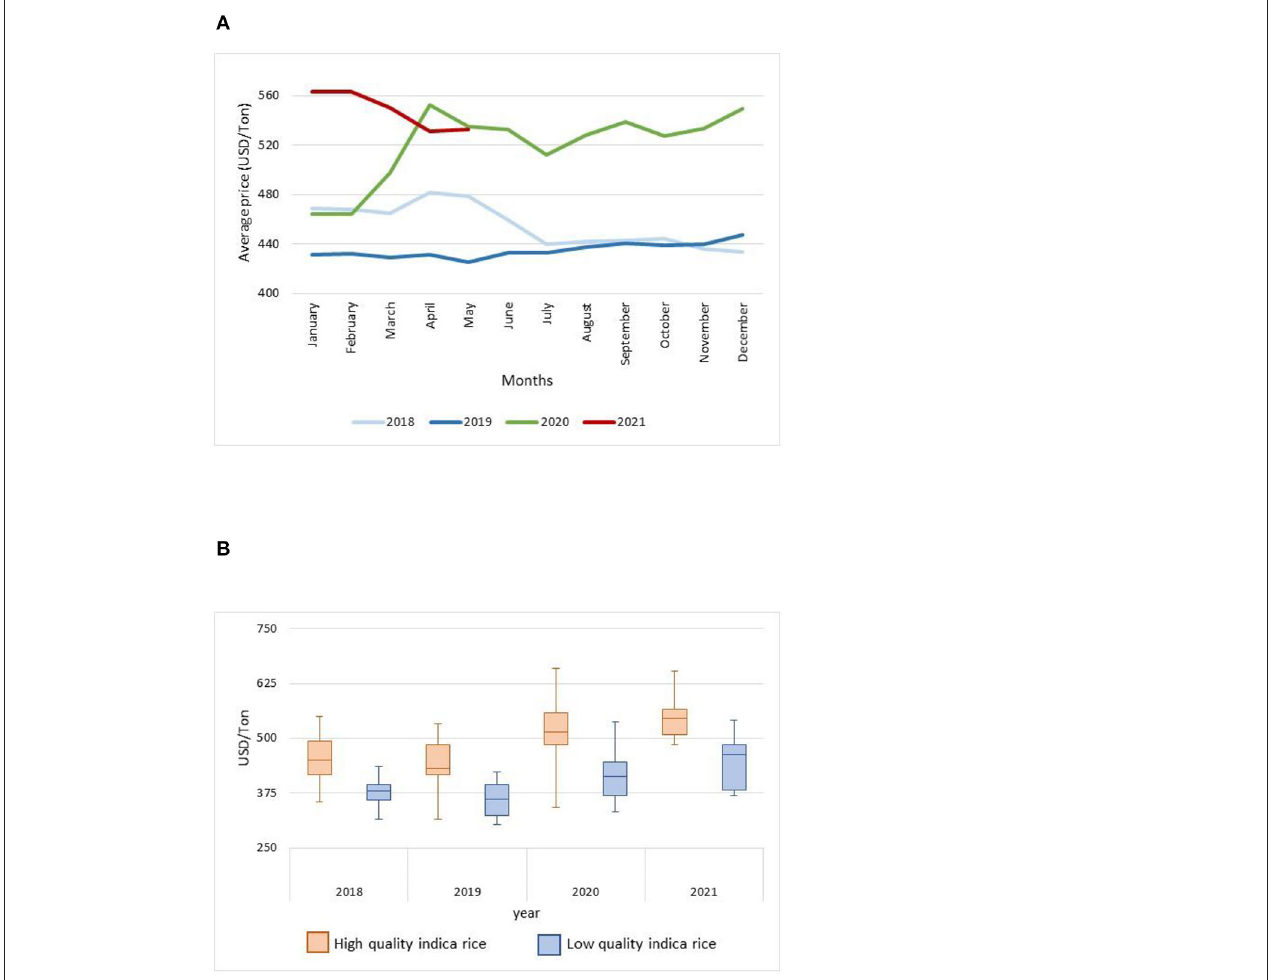
FIGURE 3 | Price trend for all kinds of rice products during COVID-19. (A) Yearly trend of average high-quality indica rice price before and after COVID-19. Average international price of reference (monthly) for selected High-Quality Indica Rice (United States Long grain 2.4%, Uruguay Long grain 5%, Thailand 5% broken, Thailand Parboiled 100%, Thai 100% B, Vietnam 5% broken). After COVID is considered past 2020. (B) International reference range of prices for high- and low-quality indica rice before and after COVID-19. Graph-box presents maximum and minimum prices at the end of the box and median at the center accompanied by percentiles 25 and 75% for the upper and lower box boundary. Average international price of reference (monthly) for selected High-Quality Indica Rice (United States Long grain 2.4%, Uruguay Long grain 5%, Thailand 5% broken, Thailand Parboiled 100%, Thai 100% B, Vietnam 5% broken) and Low-Quality Indica Rice (Vietnam 25% broken, India 25% broken, Pakistan 25% broken, Thailand 25% broken, and Thai A1 Super). After COVID is considered past